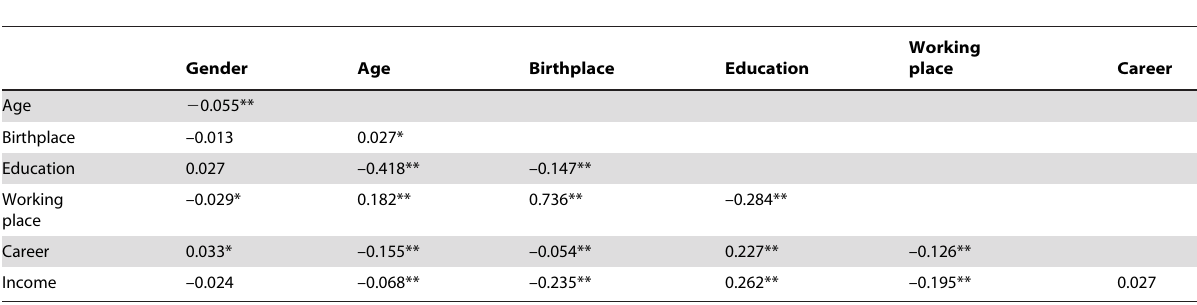
Table 2. Kendall’s tau-b Coefficient Results of Independent Variable